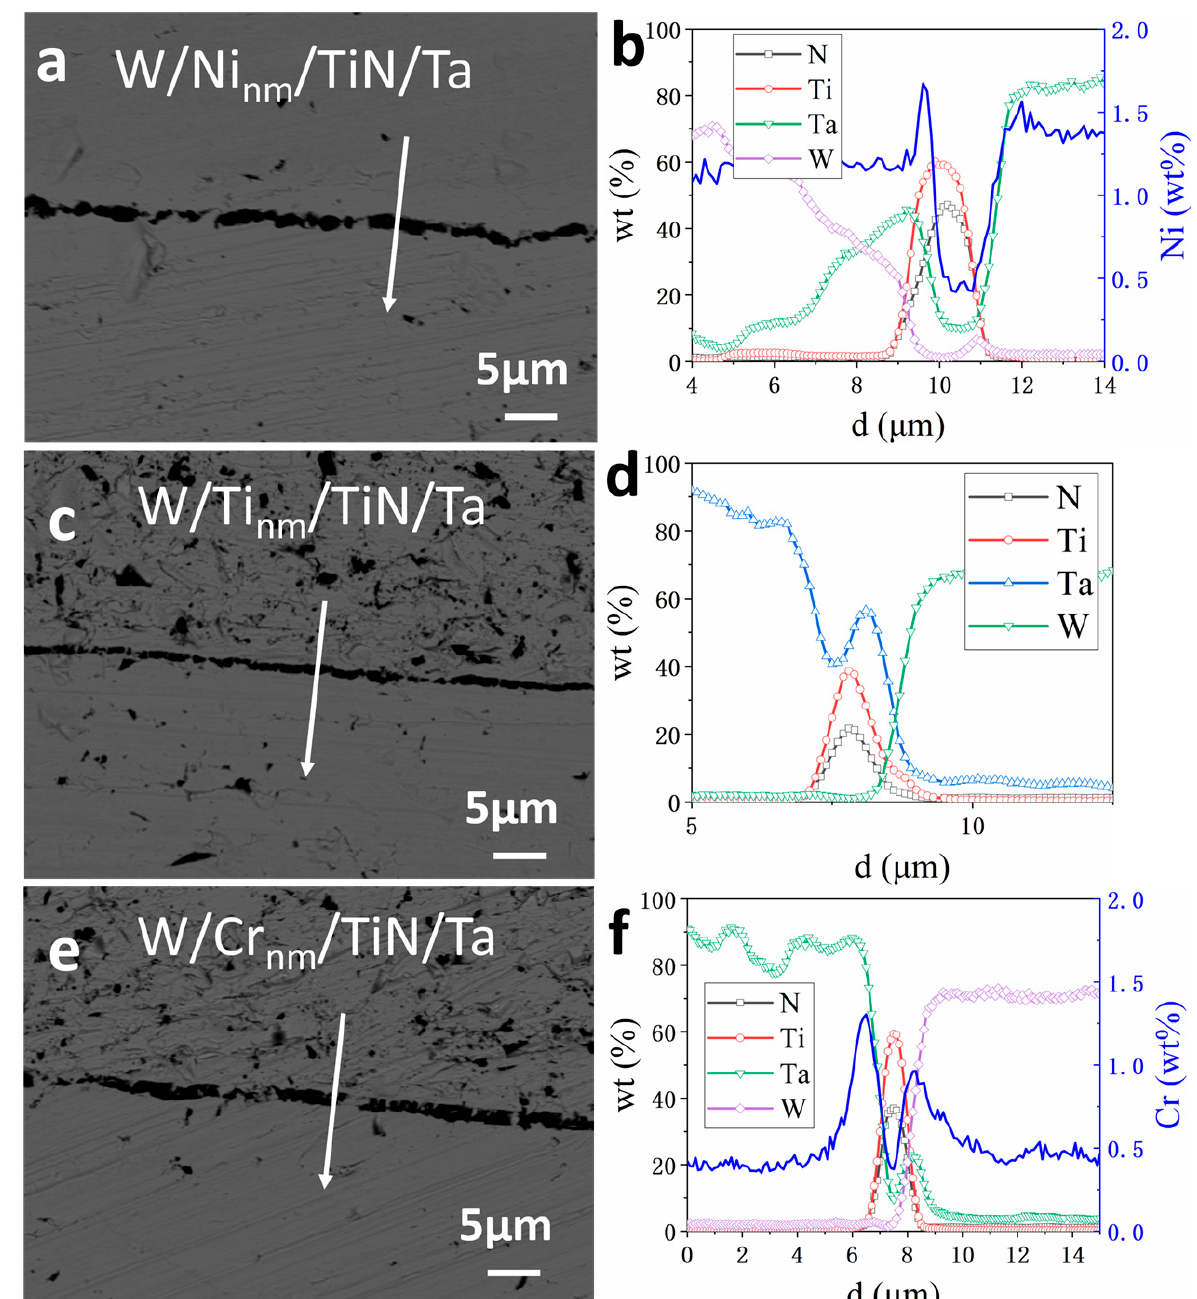
Figure 4. Element distribution near the interface of W/M nm /TiN/Ta-laminated composites joined at 1400 °C: ( a , b ) W/Ni nm /TiN/Ta, ( c , d ) W/Ti nm /TiN/Ta, ( e , f ) W/Cr nm /TiN/Ta.